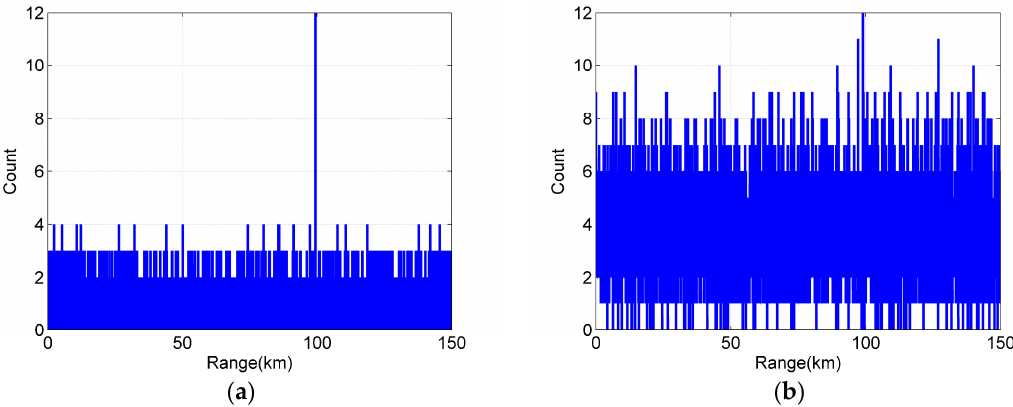
Figure 6. Histogram. ( a ) Macro pulse method (rough time bin 8 ns). ( b ) Pulse accumulation method (rough time bin 140 ns).